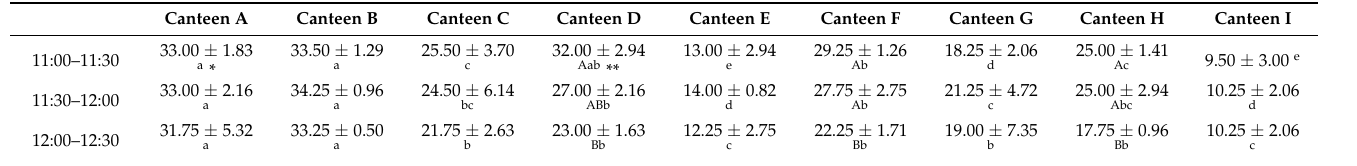
Table 2. Score of healthiness of ingredients and food content by time points in nine